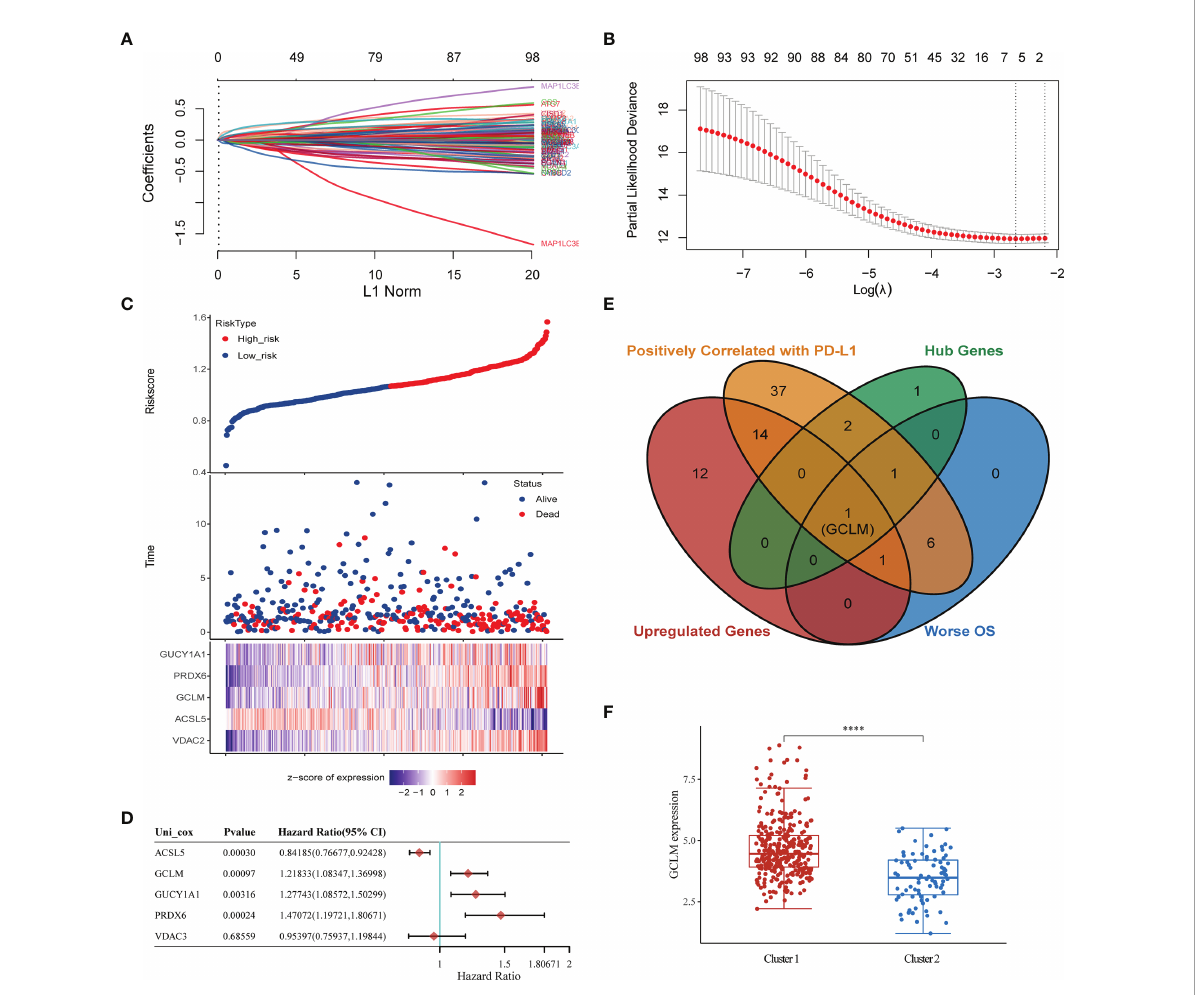
FIGURE 5 Identi fi cation of GCLM as the potential immune-related ferroptosis regulator in BCa. (A) Lasso regression of ferroptosis regulators in BCa. (B) The optimal lambda value in Lasso model. (C) Prognostic analysis of gene signature including 5 hub ferroptosis regulators. (D) The prognosis of 5 hub genes in BCa via Cox regression method. (E) A Venn diagram displayed that GCLM is the potential key ferroptosis regulator in BCa. (F) The relative expression of GCLM in Cluster 1 and 2. ****p <